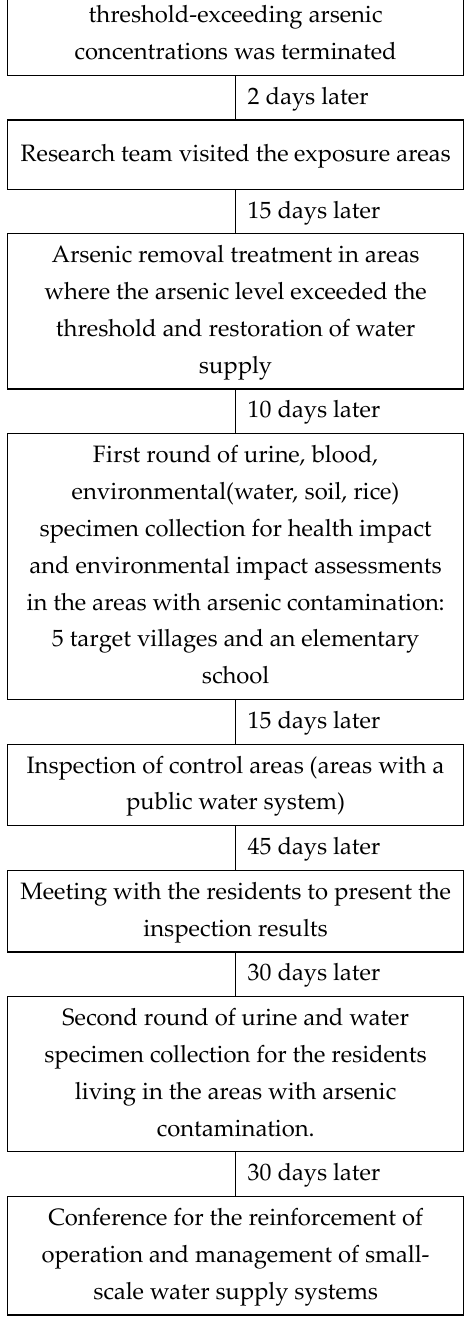
Figure 1. Survey flow.